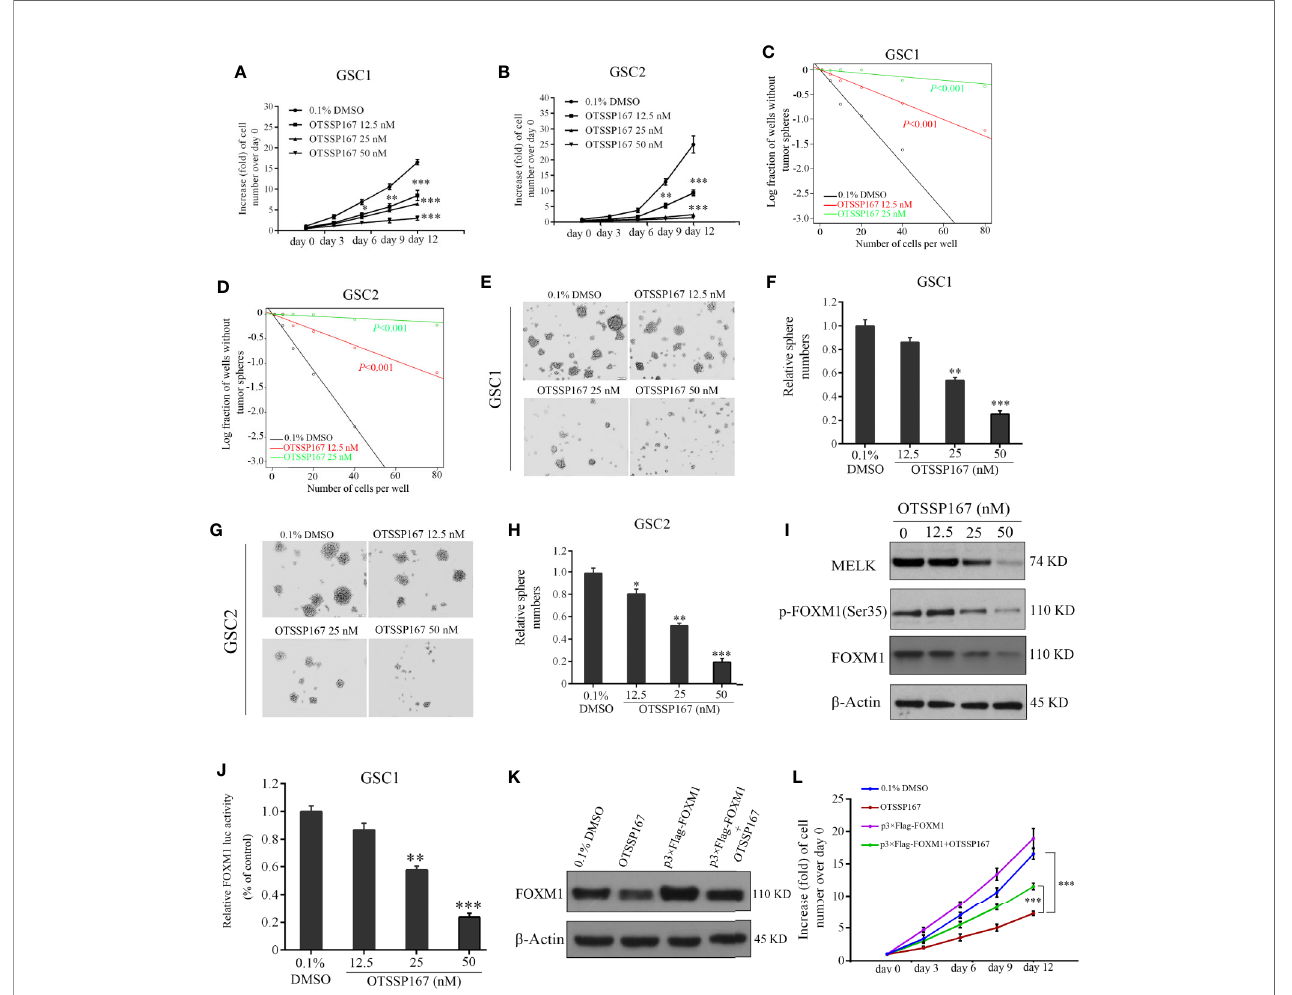
FIGURE 5 | OTSSP167 decreases GSCs proliferation and neurosphere formation by inhibiting the phosphorylation and transcriptional activation of FOXM1. (A, B) Effects of OTSSP167 on cell viability in GSC1 (A) and GSC2 (B) . Cells treated with OTSSP167 were plated in triplicate wells in stem cell media, and then cell viabilities were assessed at the indicated times (day 0 – day 12). In vitro limiting dilution assays of GSC1 (C) and GSC2 (D) treated with indicated does of OTSSP167 or 0.1% DMSO. (E – H) Effects of OTSSP167 on GSCs neurosphere formation. Representative images of GSC1 (E) and GSC2 (G) neurosphere and the quanti fi cation of sphere numbers of GSC1 (F) and GSC2 (H) treated with indicated doses of OTSSP167 or DMSO. (I) Immunoblot analysis of MELK, p-FOXM1(Ser35), FOXM1 and b -actin in GSC1 treated with indicated doses of OTSSP167. (J) OTSSP167 inhibits the transactivation ability of FOXM1. Relative FOXM1 luciferase activity normalized with respect to corresponding renilla luciferase activity is shown. (K) The expression levels of FOXM1 were detected by western blot to check the FOXM1 cDNA plasmid transfection ef fi cacy. (L) In vitro cell viability assay of FOXM1 overexpression in GSC1 cells treated with 25 nM OTSSP167 or the vehicle control. All the Data are presented as means ± SEM. * P < 0.05, ** P < 0.01, *** P < 0.001 compared with the 0.1% DMSO treated